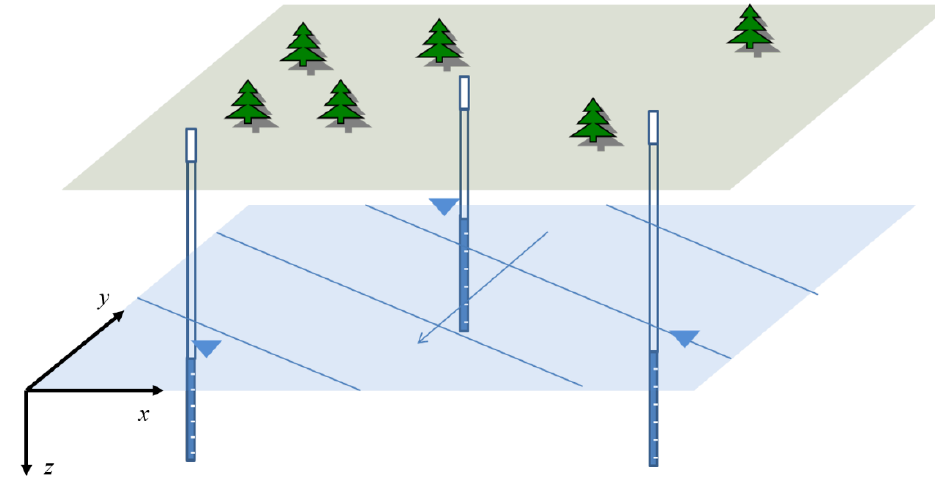
Figure 4. Three wells used to resolve the plane of the groundwater surface below an area of interest.